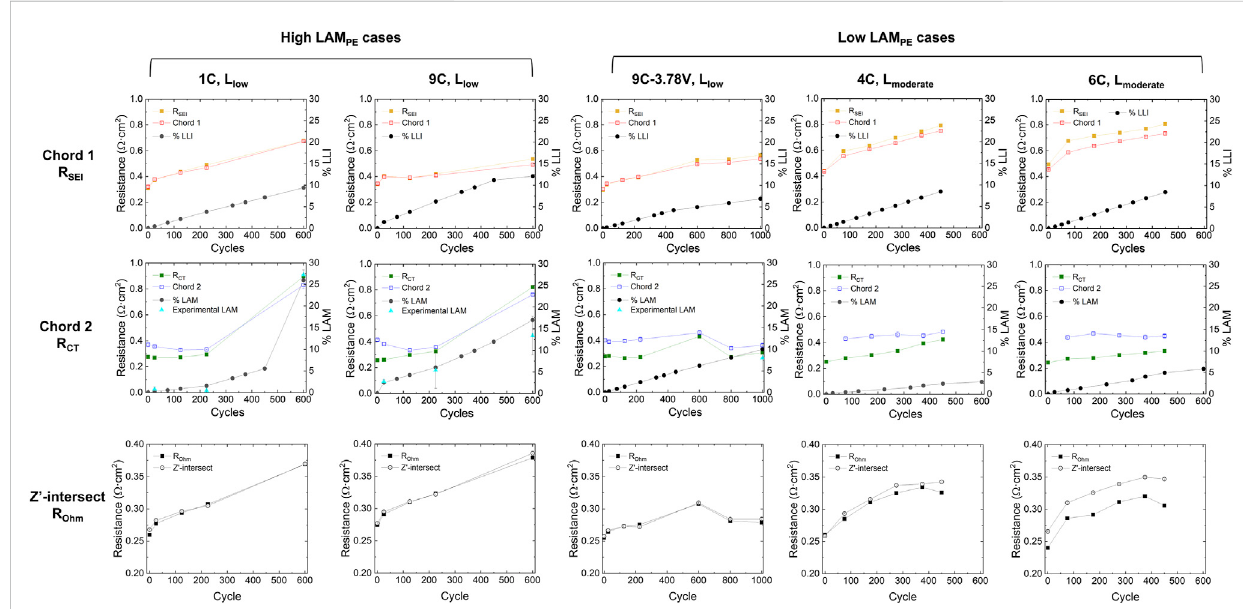
FIGURE 5 Comparison between representative results from the quick EIS fi tting and conventional equivalent circuit fi tting. The chord lengths were obtained using the quick EIS fi tting method. The R SEI , R CT , and R Ohm values were the fi tting results using ECM. The %LAM and %LLI were obtained using IC analysis and half-cell tests. The growth trend between the chord length and resistance are consistent with each other. This trend is also in harmony with the %LLI and %LAM PE obtained from IC analysis and half-cell tests. The experimental LAM PE data points (light blue triangles) were based on half-cell test results using cathode materials retrieved from used pouch cells. Note that the second chord length (Chord 2) of 4C, L moderate and 6C, L moderate at the beginning of life (cycle 0) are not shown due to not-converged fi tting results.